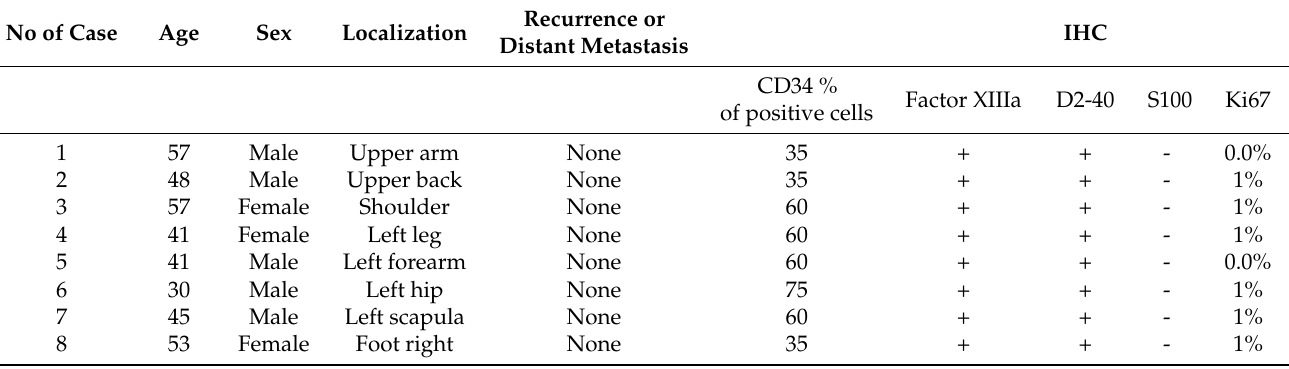
Figure 3. Dermatofibromas with an aberrant CD34 protein expression. Table 3. A current group of dermatofibromas with aberrant expression of CD34 protein